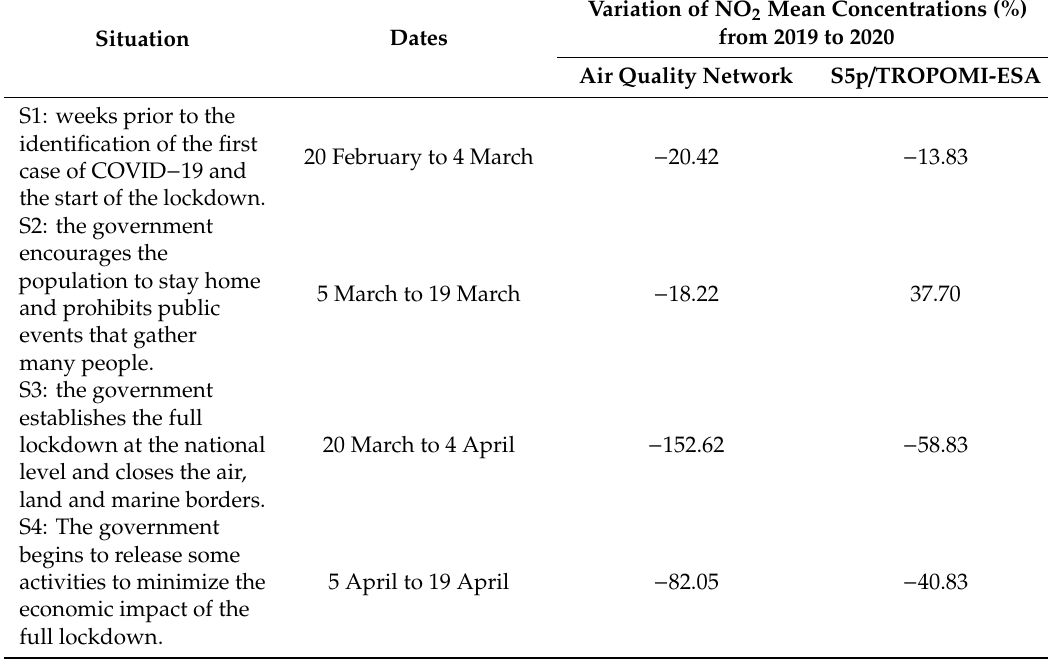
Table 2. Variation of NO 2 mean concentrations measured (%) from 2019 to 2020 from the quality network and S5p / TROPOMI-ESA for